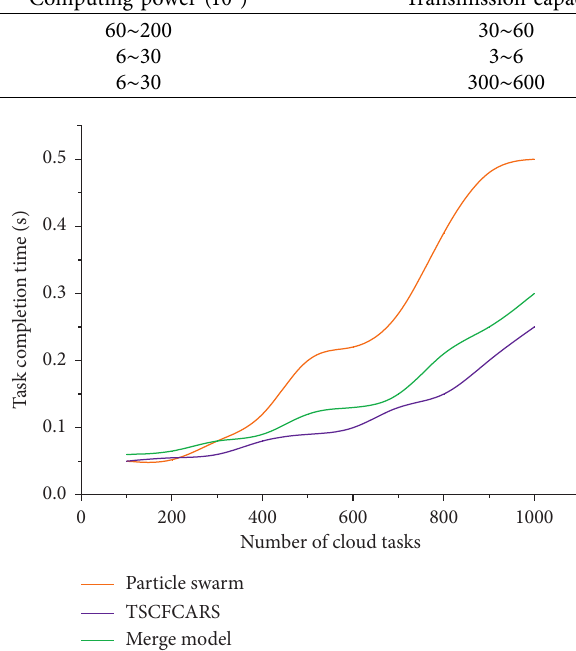
Figure 6: Comparison of scheduling time when there are many cloud service tasks.